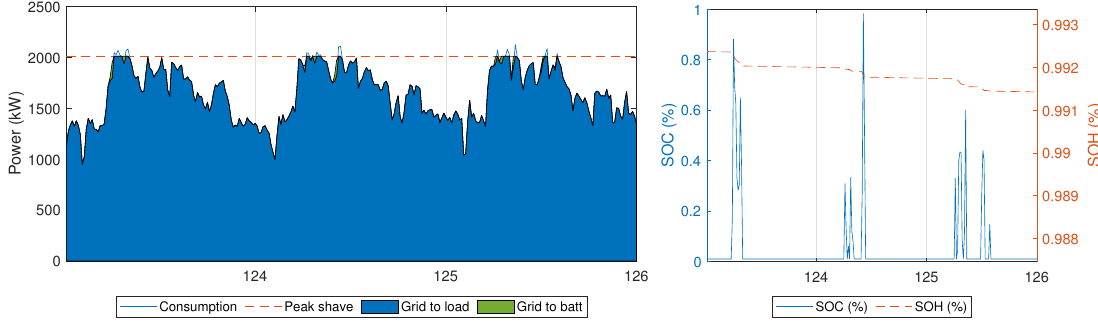
Figure 9. Power flow analysis for a three-day period: load and power flows within the system ( left ); time correlated evolution of battery state of charge (SoC) and resulting state of health (SoH) decline ( right